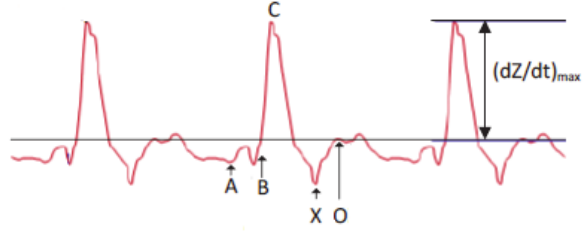
Fig.2: A typical ICG